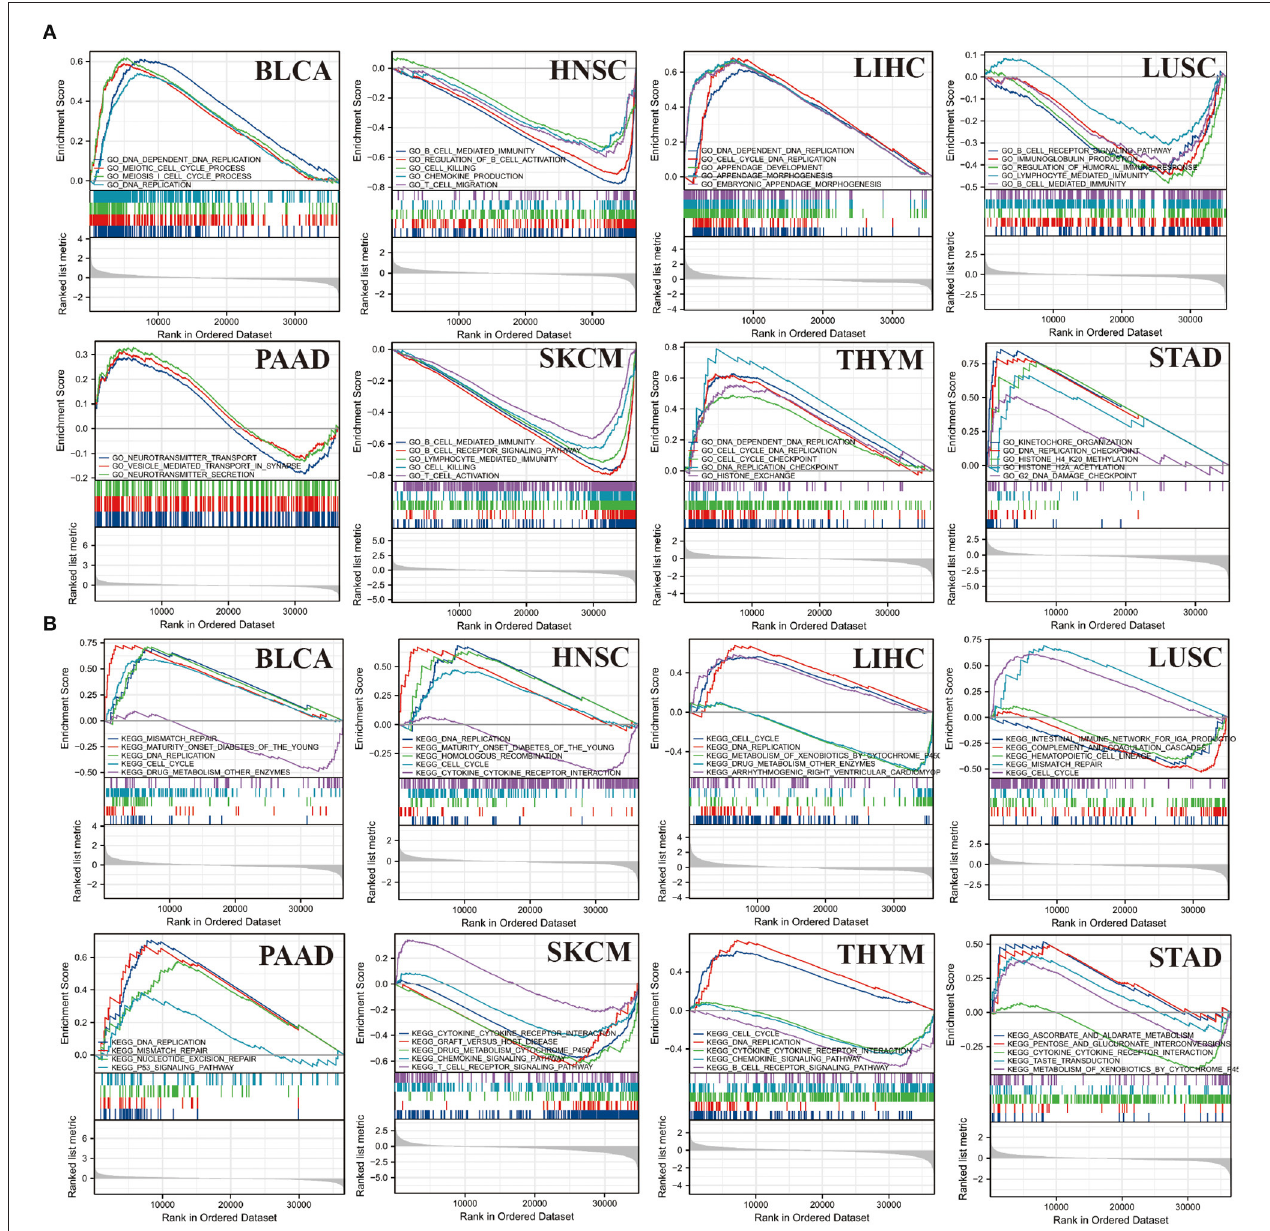
FIGURE 14 | Outcomes of GSEA. (A) GO function annotation of CBX3 in a variety of tumors. (B) KEGG pathway analysis of CBX3 in a variety of tumors. Dissimilar colored curves display distinct roles or pathways regulated in diverse tumors. Peaks on the downward curve designate negative regulation while Peaks on the upward curve designate positive